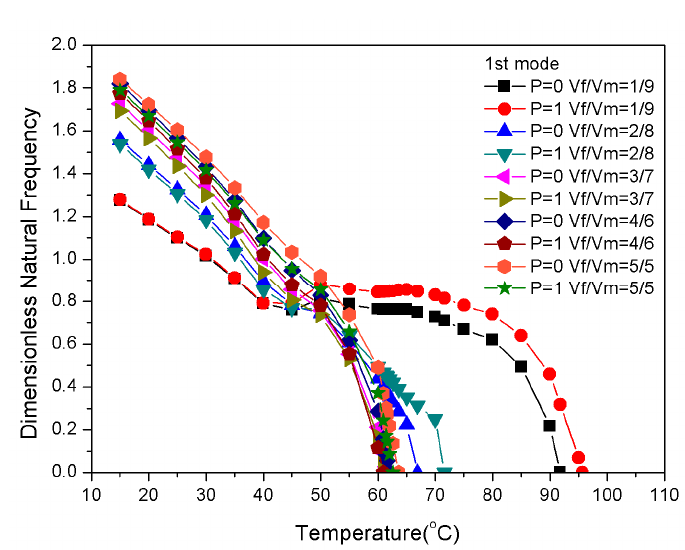
Figure 10. The percentage of graphite in each ply.